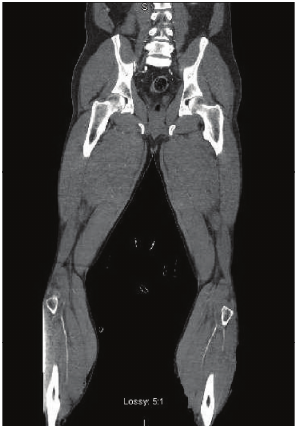
Figure 1: CT angiogram of the lower limbs showing marked narrowing of the distal vessels (arterial and venous) but no occlusive